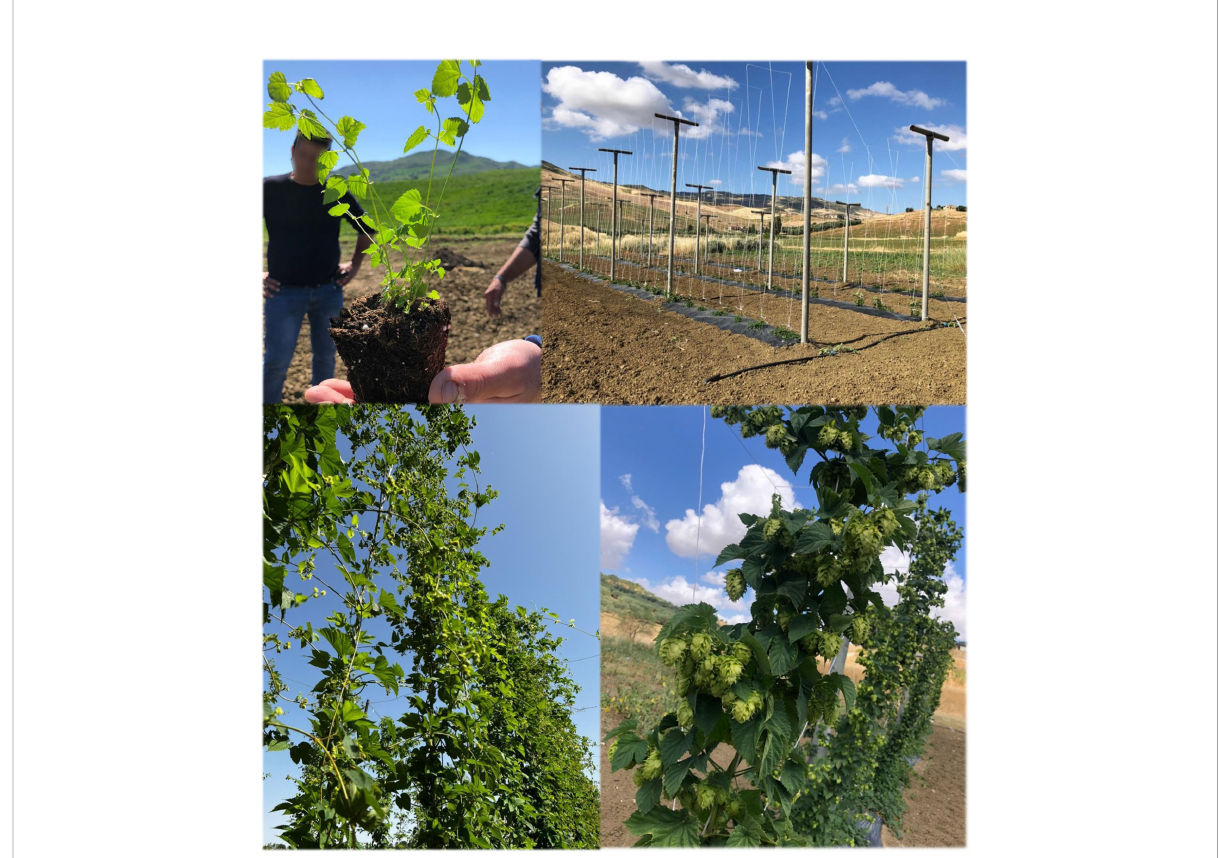
FIGURE 1 Pictures taken during the fi rst year of hop cultivation in a Sicilian semi-arid environment at the “ Sparacia ” farm (37°38 ’ 07 ” N; 13°45 ’ 47 ” E; 450 m a.s.l.), Department of Agricultural, Food and Forest Sciences (D/SAAF), University of